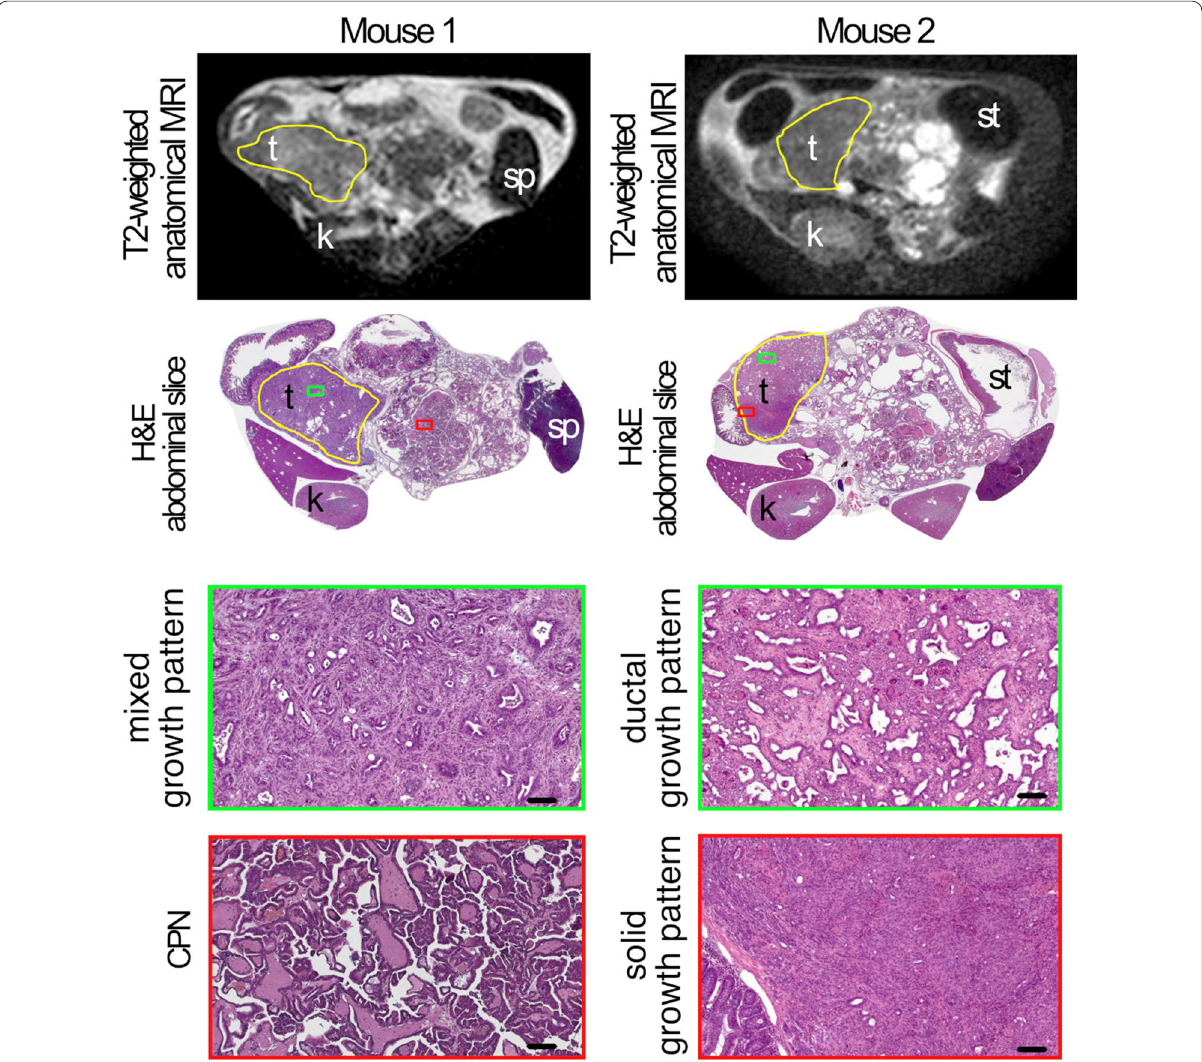
Fig. 3 Complex co-registration of anatomical magnetic resonance imaging (MRI) images to histological slides in the transverse plane of abdomen of a mouse (t tumor, k kidney, st stomach, sp spleen) showing variable tumor growth patterns in different matching regions. Unpublished = = = =